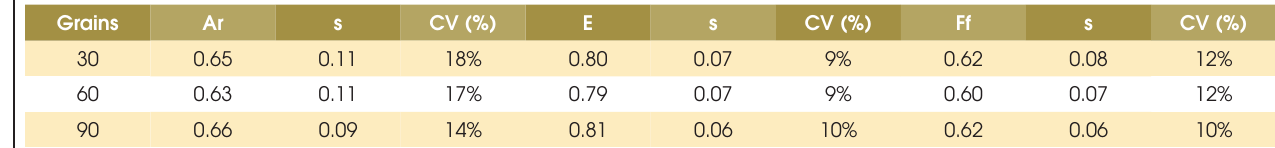
Table 5 – Form factors calculated for samples with different numbers of grains